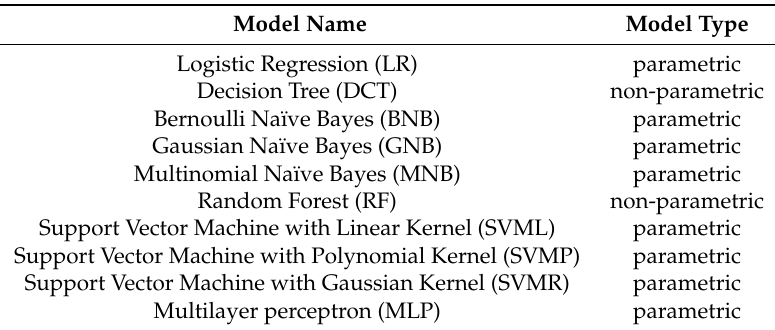
Table 4. Machine-learning algorithms and their